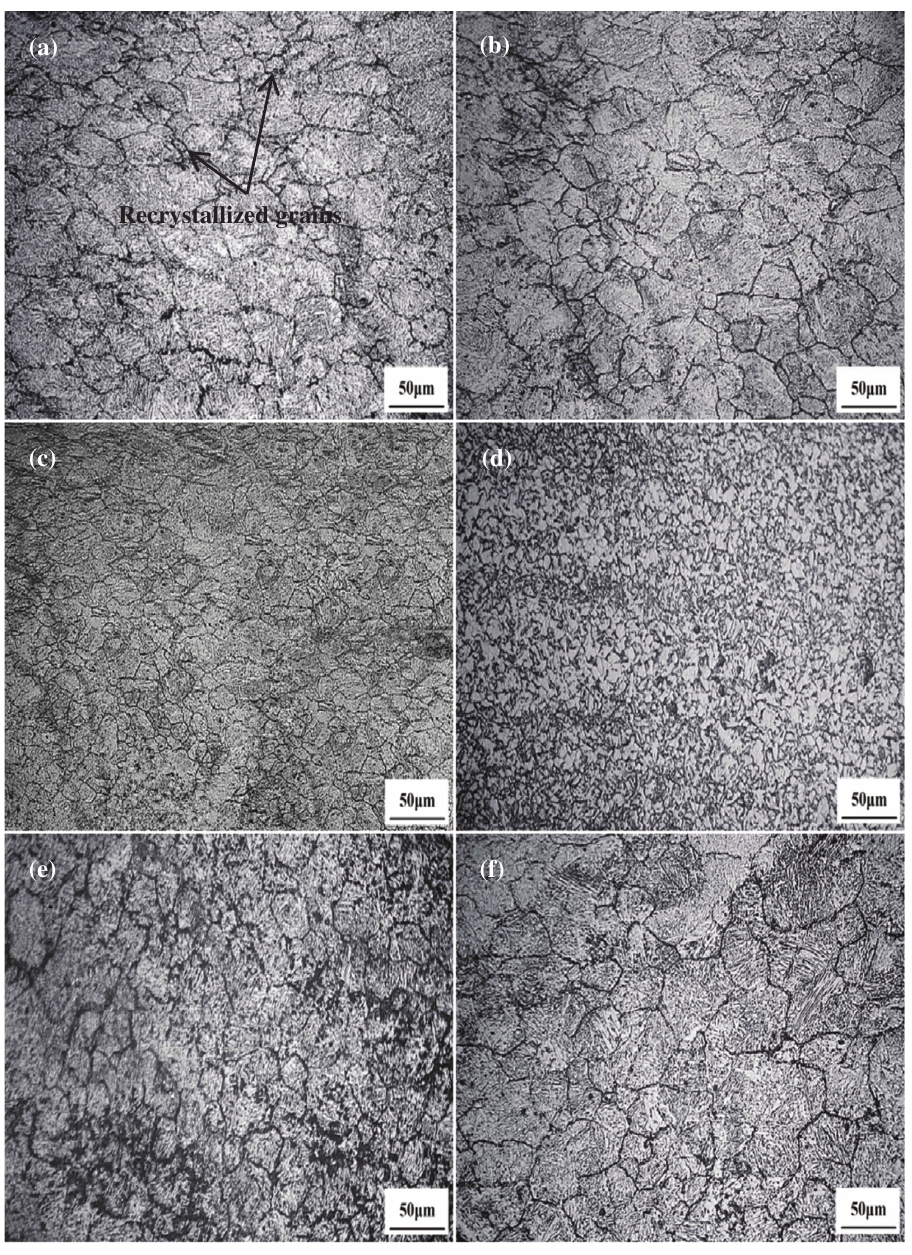
Figure 2: The compression deformation microstructure of samples under temperatures of 850 – 1,200°C (a) 850°C (b) 900°C (c) 950°C (d) 1,050°C (e) 1,100°C (f)